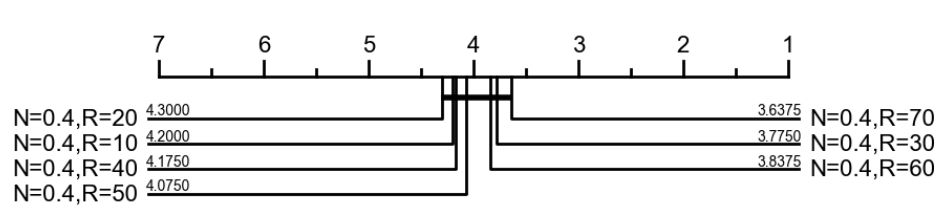
Figure 6. Mean rank of different noise intensities applied on CEEMD-MultiRocket with a fixed number of realizations.